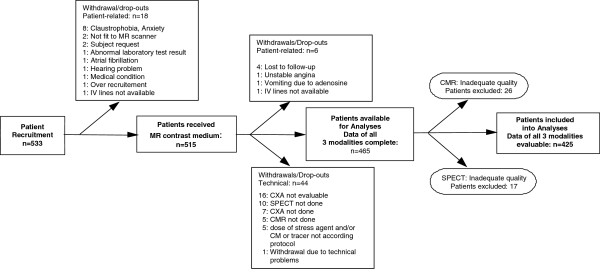
Flow Chart. Flow chart demonstrating the number of eligible patients and drop-outs. CMR: cardiovascular magnetic resonance; CM: contrast medium (Gd-DTPA-BMA); CXA: coronary X-ray angiography; Pats: patients. SPECT: single-photon-emission-computed-tomography.